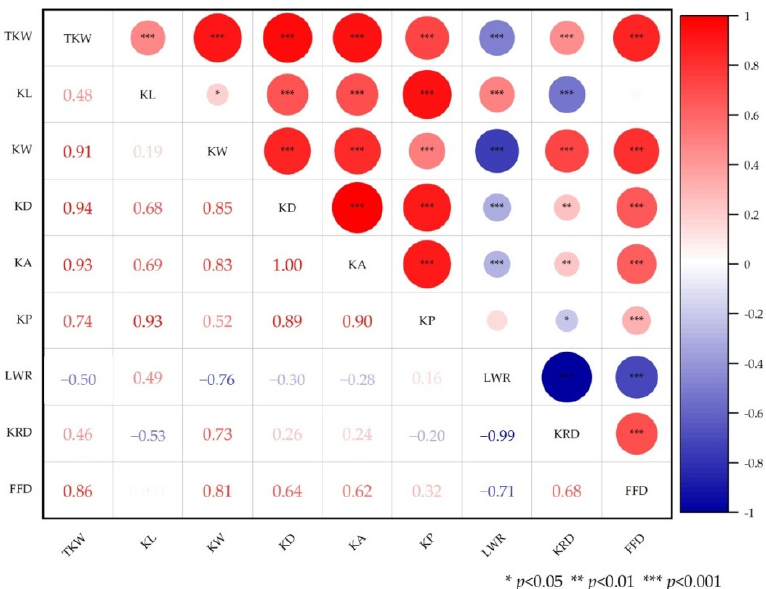
Figure 2. Phenotypic performances, distribution, and correlation coefficients of thousand-grain weight (TKW), kernel length (KL), kernel width (KW), kernel diameter (KD), kernel surface area (KA), kernel perimeter (KP), the ratio of KL and KW (LWR), kernel roundness (KRD) and the form-density factor (FFD) in the ZK-RILs based on the BLUP data. *, ** and *** represent significance at p < 0.05, p < 0.01 and p < 0.001, respectively.